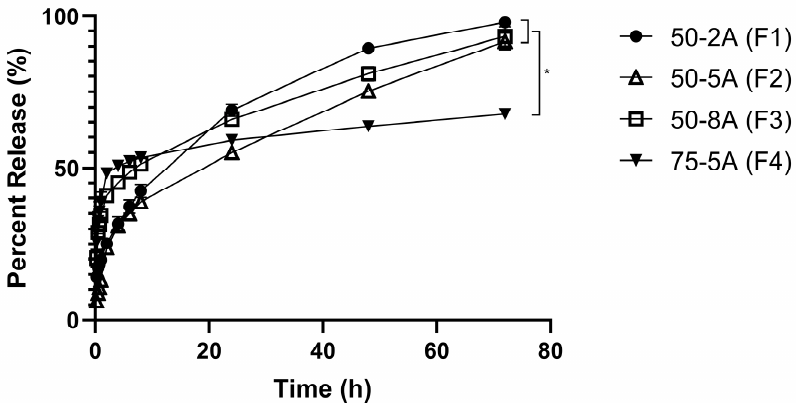
Figure 2. In vitro drug release profile from different types of PLGA ( n = 6).